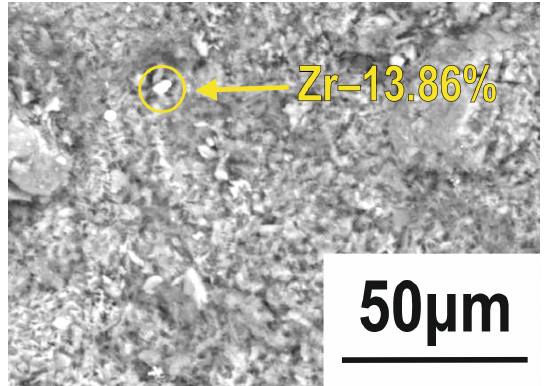
Figure 8. SEM image of the spectral surface with the indicated location of the zirconium inclusion.